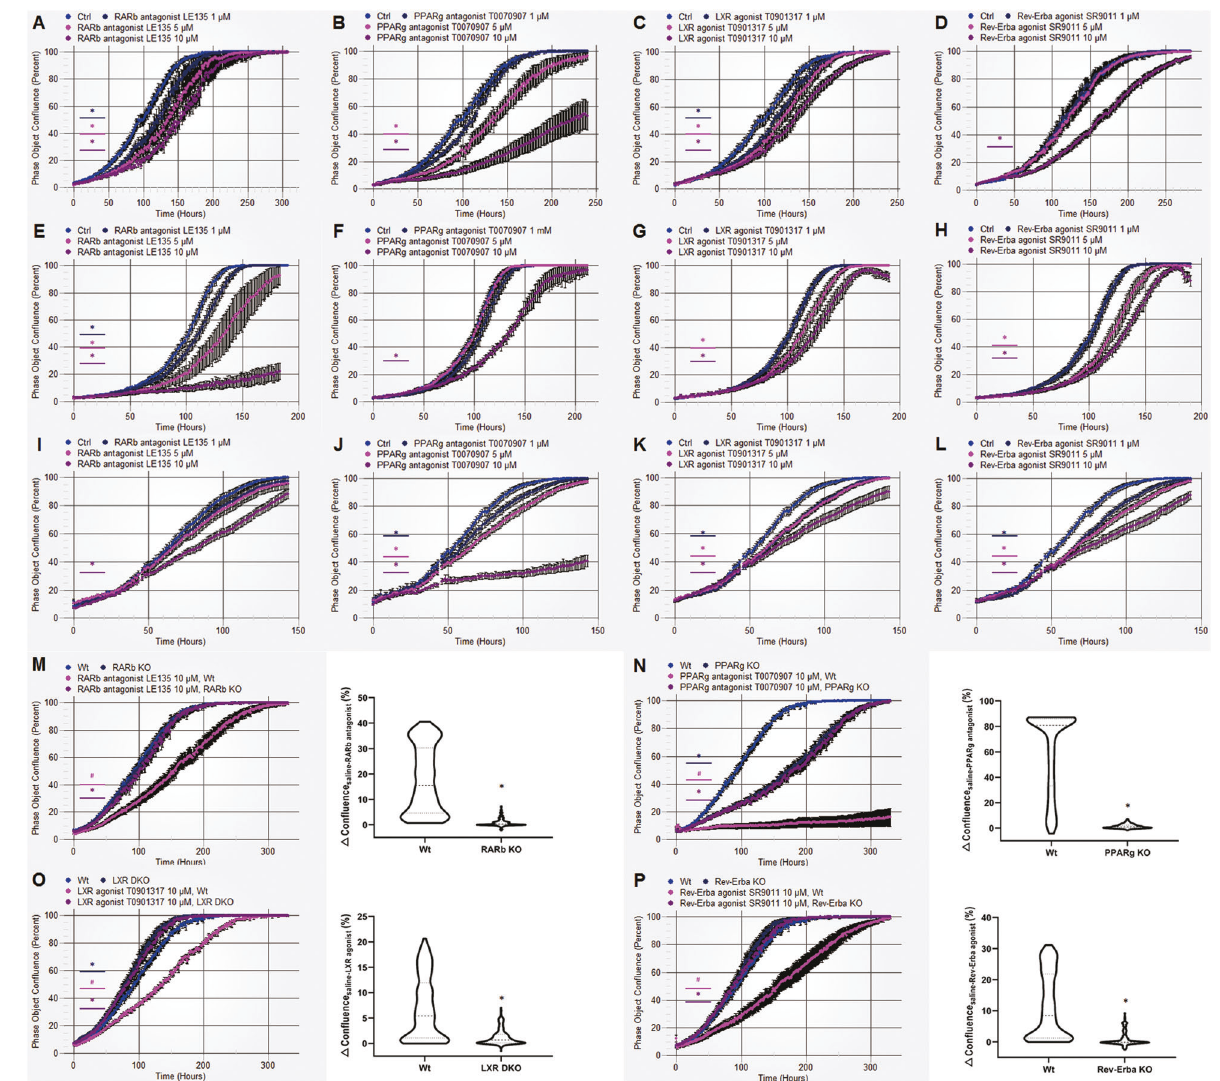
Fig. 2 NR modulators inhibited osteosarcoma cell growth by speci fi cally targeting NRs in a dose-dependent manner. A – D U2OS, E – H HOS-MNNG, and Saos-2 ( I – L ) cells were treated with the RARb antagonist, PPARg antagonist, LXR agonist and Rev-Erba agonist at gradient concentrations (1, 5, or 10 μ M). The cell con fl uence was evaluated in real time by the IncuCyte zoom living cell imaging system. n = 6; *P < 0.05, the NR modulator group versus the Ctrl group. M – P Wild-type (Wt) and NR-knockout (KO) U2OS cells were treated with the corresponding NR modulators at a concentration of 10 μ M. The cell con fl uence was evaluated in real time by the IncuCyte zoom living cell imaging system. Mean ± SD, n = 6; *P < 0.05, the NR-KO group versus the Wt group. # P < 0.05, the NR modulator group versus the saline group. △ Con fl uence represents the difference in con fl uence between the saline group and the NR modulator group. The violin plots show the distribution of the △ Con fl uence of the indicated genotypes. Paired t -tests were used to evaluate the signi fi cance. *P < 0.05, the NR KO group versus the Wt